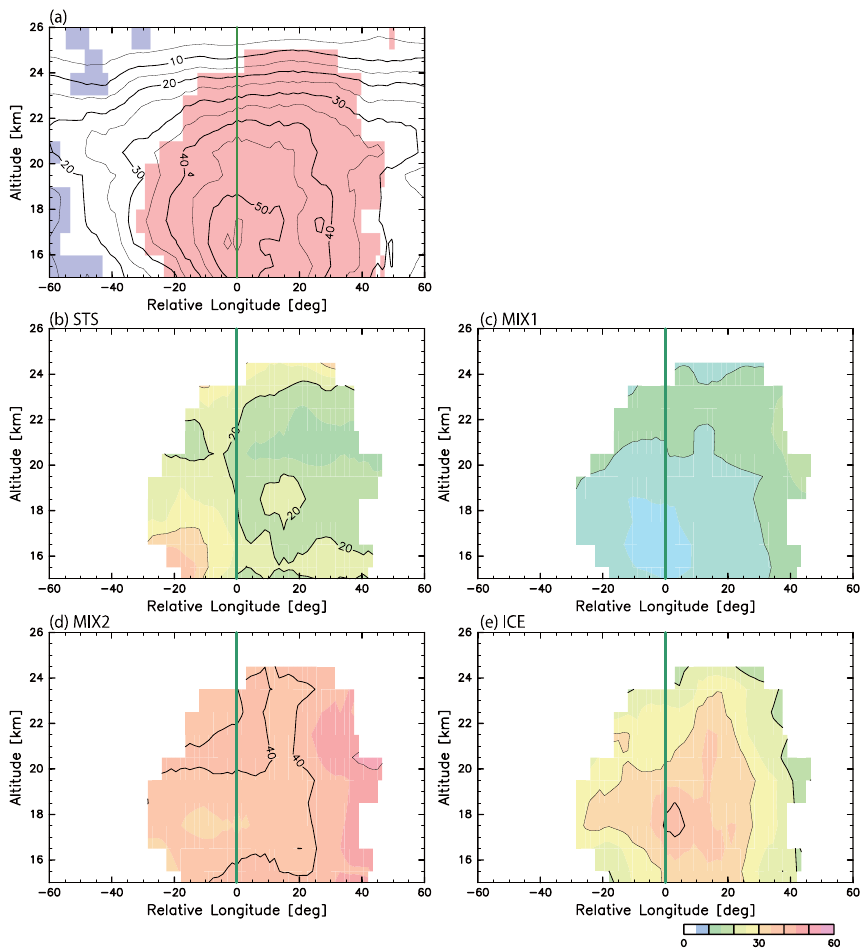
Fig. 11. (a) The same as Fig. 7 but for August of 2007–2011. The number of cases used for the composite is 107. (b–d) The same as (a) but for the proportion for each PSC composition: (b) STS, (c) Mix1, (d) Mix2 and (e) Ice. Coloring corresponds to the significantly high PSC/UC frequency regions in (a) . Contour interval is